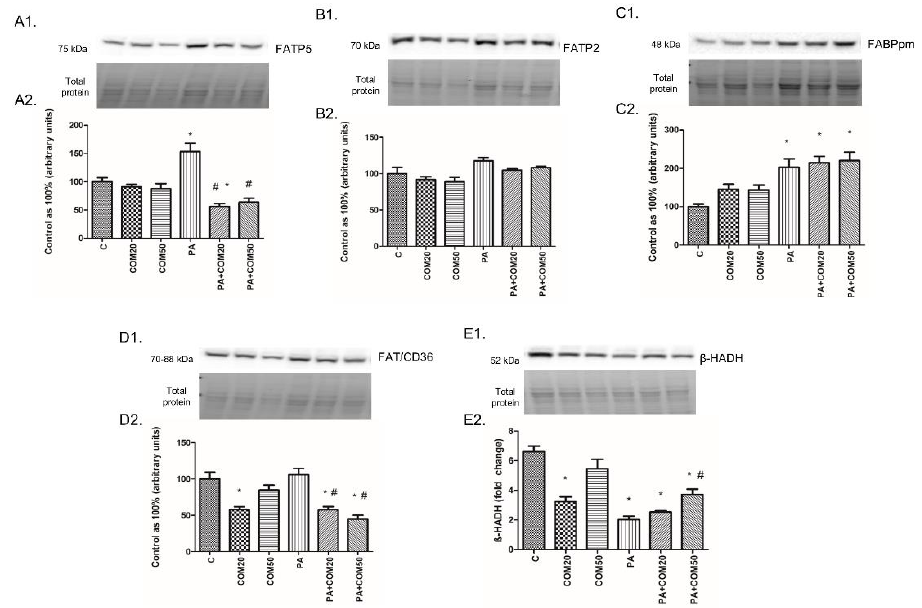
Figure 6. Representative Western blot membranes of evaluated proteins, i.e., FATP5 ( A1 ), FATP2 ( B1 ), FABPpm ( C1 ), FAT/CD36 ( D1 ), β-HADH ( E1 ), and the corresponding images of total protein staining after membrane transfer used for normalization. The expression of proteins involved in fatty acid uptake, i.e., FATP5 ( A2 ), FATP2 ( B2 ), FABPpm ( C2 ), FAT/CD36 ( D2 ), and β-oxidation, namely, β-HADH ( E2 ) in primary rat hepatocytes. The cells were incubated with presence or absence of PA (0.5 mM) or/and COM (20 or 50 μM), as it was described in Materials and Methods section. The protein expression was evaluated by the Western blot technique. The data are shown as the mean ± SD and are based on six independent determinations (n = 6); * p < 0.05 significant difference vs. control group; # p < 0.05 significant difference vs. palmitate group; C, control; COM20 or COM50, coumestrol 20 or 50 μM; PA, palmitic acid; PA + COM20 or PA + COM50, palmitic acid + coumestrol 20 or 50 μM.